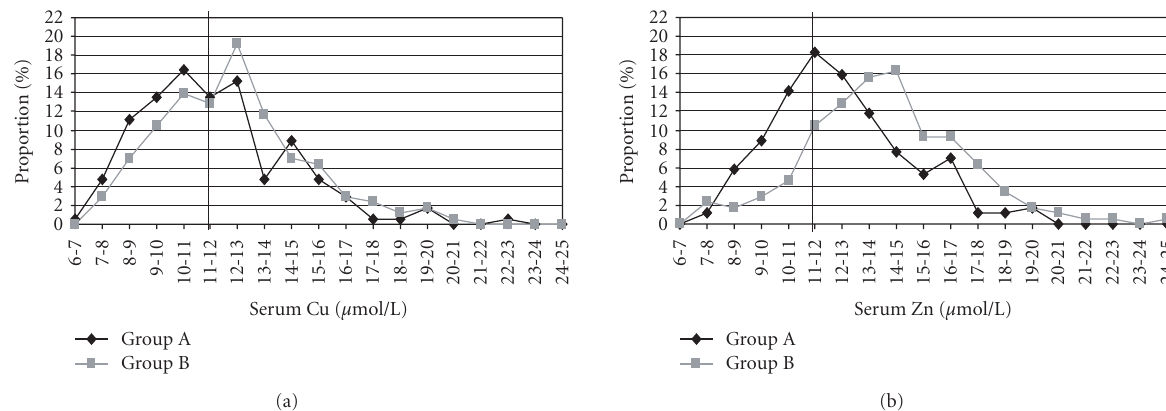
Figure 3: Distribution of all analysed serum copper (a) and zinc concentrations (b) in the di ff erent feeding groups (A and B).